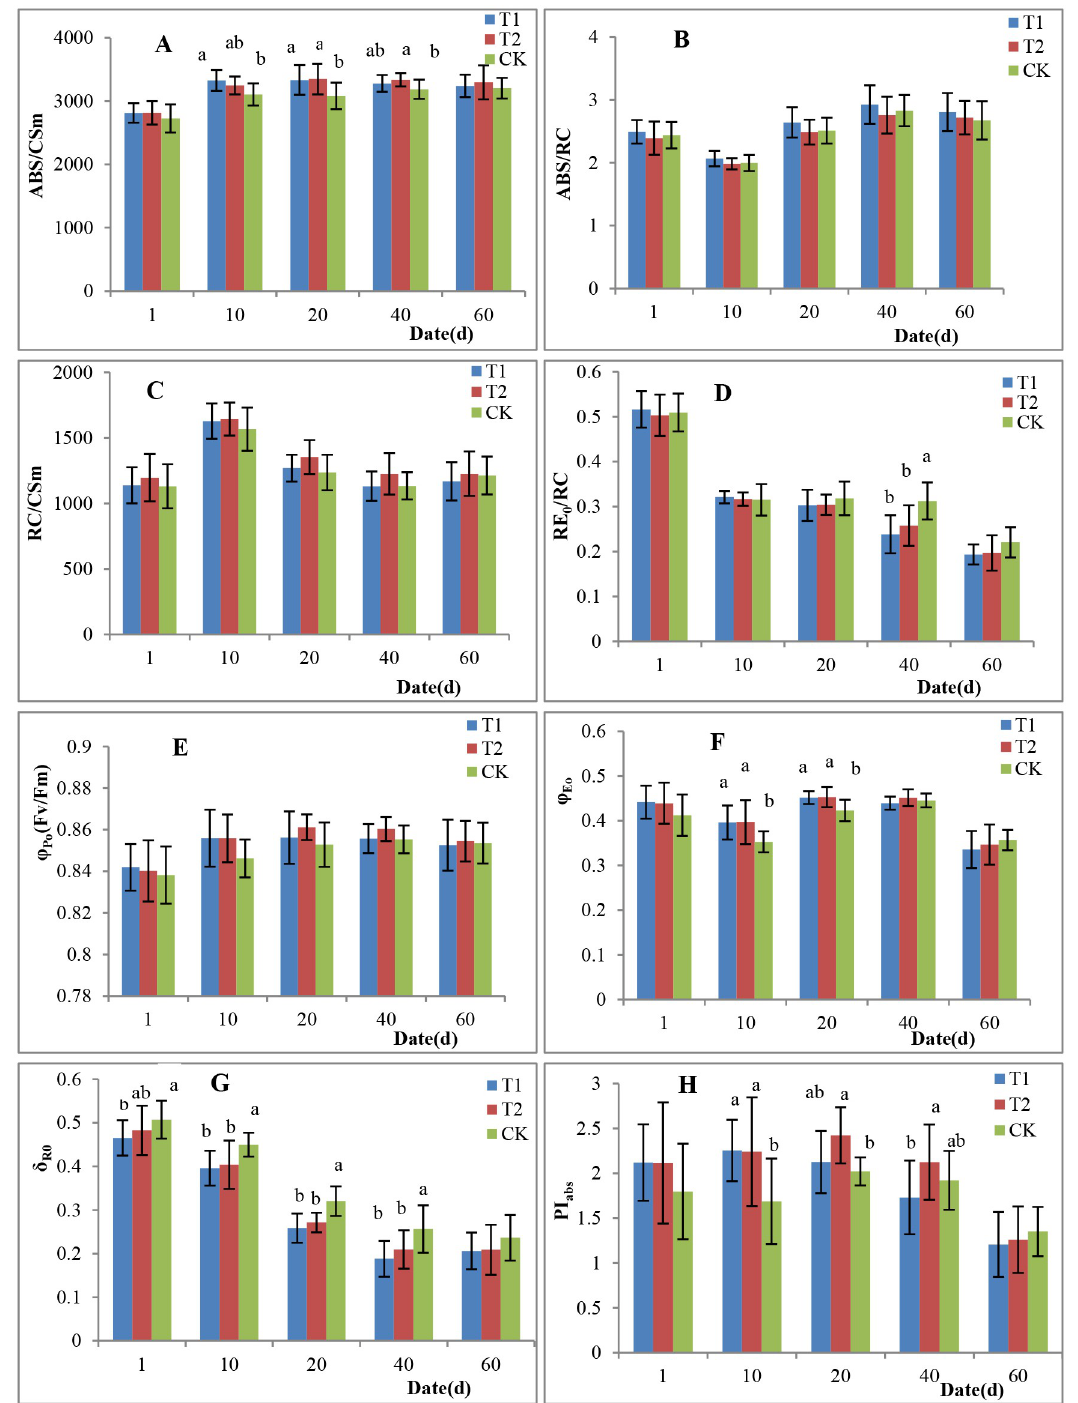
Fig 4. Effects of supplemental light on the chlorophyll fluorescence parameters of tomato leaves. A, ABS/CS (absorption flux per CS). B, ABS/RC (absorption flux per RC). C, RC/CS (density of active PSII RCs per CS). D, RE 0 /RC (electron flux reducing terminal electron acceptors at the PSI acceptor side, per RC). E, φ Po (maximum quantum yield for PSII primary photochemistry). F, φ Eo (quantum yield of electron transport). G, δ R0 (efficiency/probability with which an electron from the intersystem electron carriers moves to reduce terminal electron acceptors at the PSI acceptor side). H, PI abs (performance index). The bars (means ± SEs, n = 10) followed by the same letters are not significantly different at p < 0 . 05 .